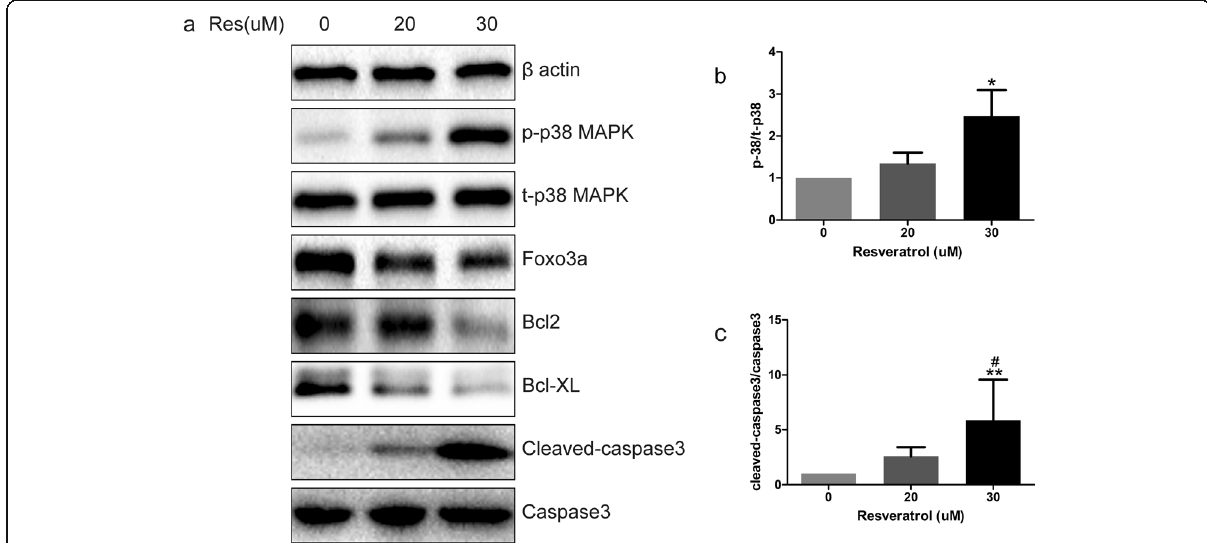
Fig. 2 Western blot analysis after administration. a Western blot stripes of β actin, p-p38MAPK, p38MAPK, Foxo3a, Bcl2, Bcl-XL, Cleaved-caspase3, Caspase3. b, c One way anova analysis was used to analysis the p-38 and cleaved-caspase3 protein expression, *P < 0.05(compared with vehicle- treated control), #P < 0.05(compared with Res 20 μ M